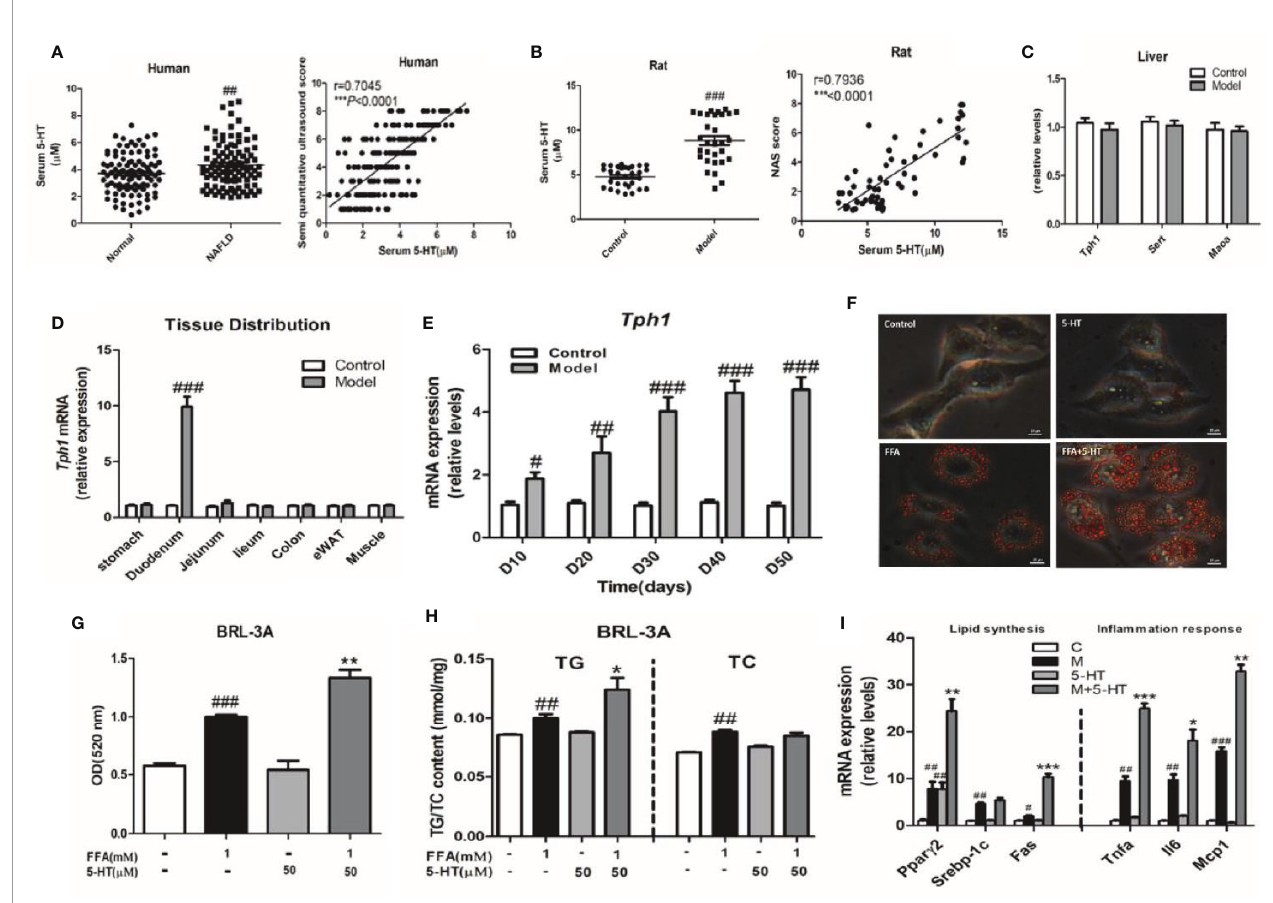
FIGURE 1 | Increased gut-derived serotonin (GDS) signaling in the duodenum was correlated with non-alcoholic fatty liver disease (NAFLD)/non-alcoholic steatohepatitis (NASH). (A) The level of serum 5-hydroxytryptamine (5-HT) and correlation analysis between serum 5-HT and semi-quantitative ultrasound score in healthy humans and patients with NAFLD (n = 100), as well as in the control and model groups (NASH SD rats) (n = 30) (B) . (C) The messenger RNA (mRNA) expression of Tph1 , Sert , and Mao a in the liver of SD rats. (D) The tissue distribution of Tph1 mRNA expression in SD rats. (E) The duodenal Tph1 mRNA expression in SD rats fed an high fat-sucrose diet (HFSD) diet for 10, 20, 30, 40, and 50 days. (F) Oil red O staining of BRL-3A (× 400). Small red circles indicate the formation of large cytoplasmic lipid droplets. (G) The lipid content in BRL-3A. (H) The content of triglyceride (TG) and total cholesterol (TC) in BRL-3A. (I) The expression of genes related to lipid synthesis ( Ppar g 2 , Srebp1c , and Fas ) and the in fl ammatory response ( Tnf a , Il6 , and Mcp1 ) in BRL-3A cells. All data are presented as the mean ± SEM (n = 6). # P < 0.05, ## P < 0.01, and ### P < 0.001, compared with the corresponding control group; * P < 0.05, ** P < 0.01 and *** P < 0.001 compared with the model